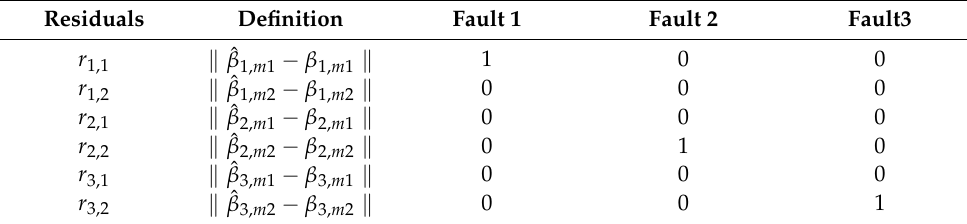
Table 1. Pitch system FDI